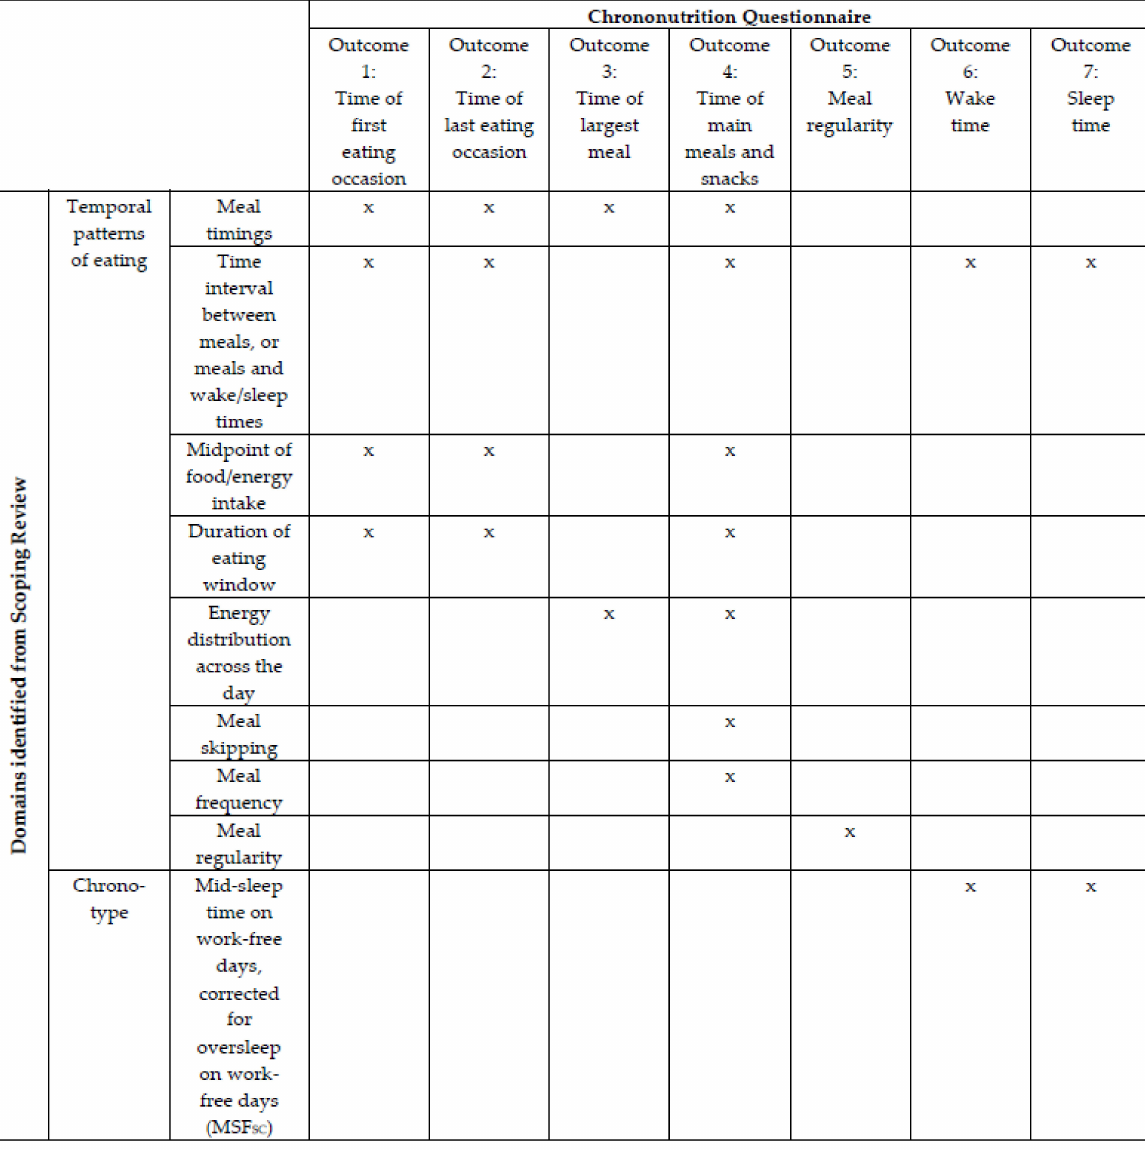
Figure 1. Domains identified by a scoping review (rows) and the seven preliminary outcomes that address them in the Chrononutrition Questionnaire (columns). “Largest meal” is defined based on portion size while “main meals” refer to breakfast, lunch, dinner, and/or supper. “x” represents the outcome that alone, or with other outcome(s) along the same row captures the domain on that